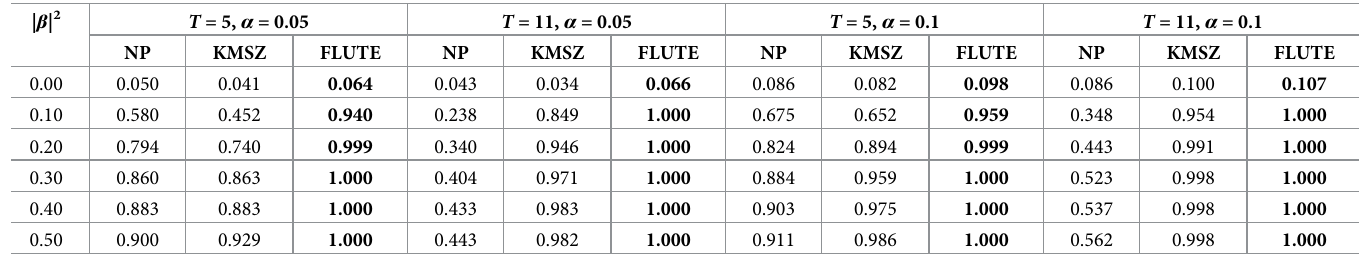
Table 4. Size and power for different correlation when K = L = 11, n = 40. | β | 2 T = 5, α =